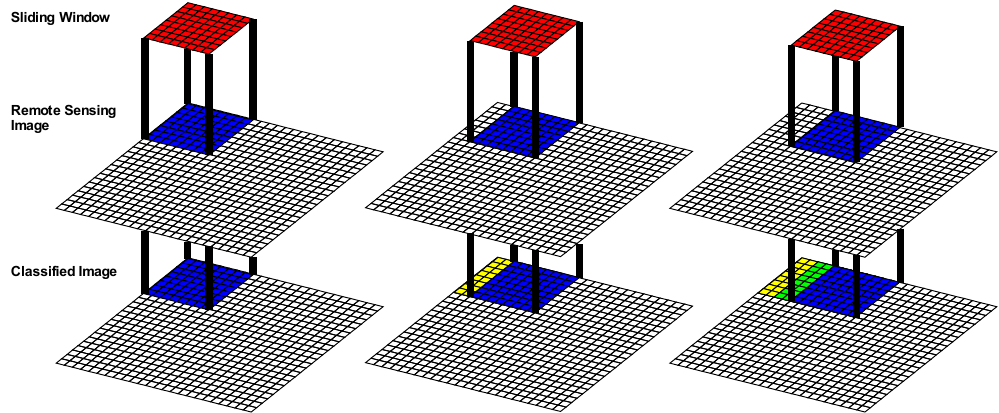
Figure 4. Classification of large images based on their subdivision into frames. The method uses a sliding window that runs the image with a certain stride. In the example, the classification uses an 8x8 window that slides over an image with a two-pixel step.